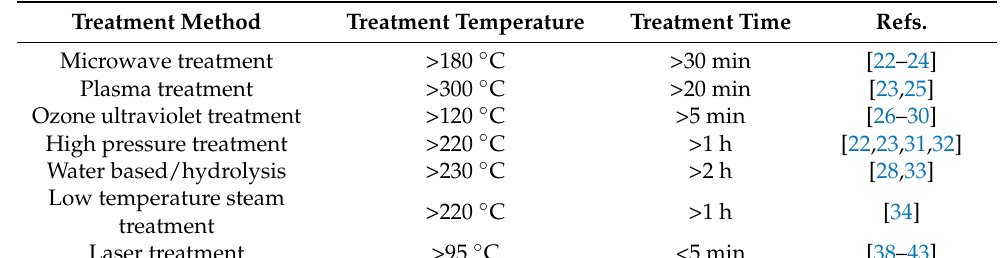
Table 1. Low temperature treatment process parameters.